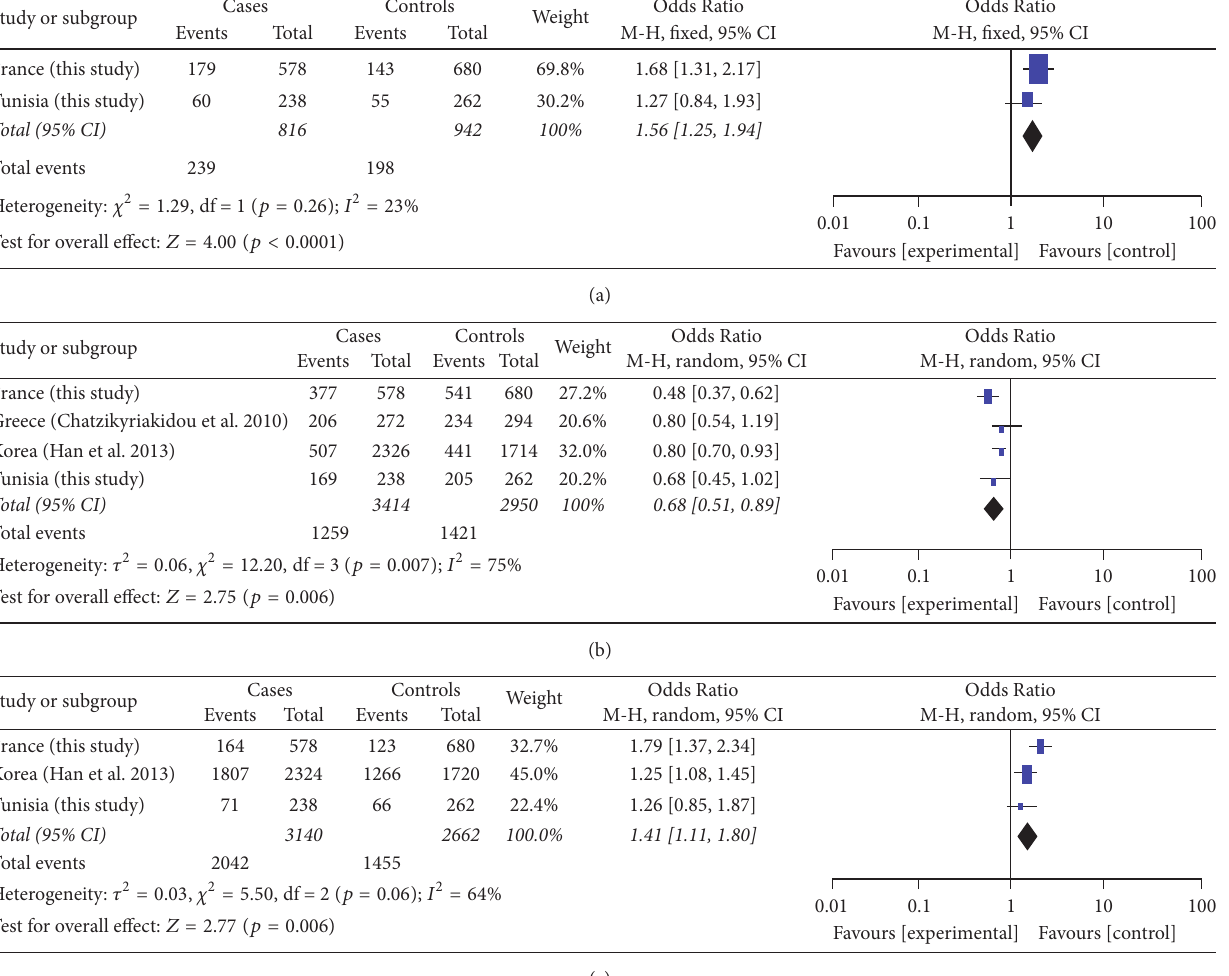
Figure 2: Forest plot of the association between TMEM187 rs13397 (a), IRAK1 rs1059703 (b), and IRAK1 rs1059702 (c) polymorphisms and RA. Meta-analyses were performed for the rs13397 (a), rs1059703 (b), and rs1059702 (c) polymorphisms, respectively, using Review Manager 5.3